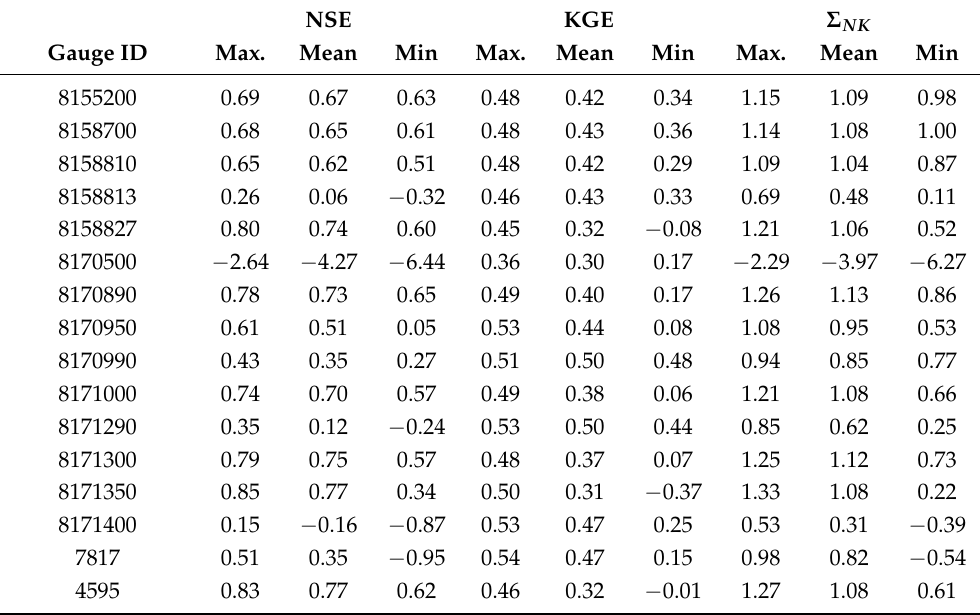
Table 6. Monthly ‘goodness-of-fit metrics’ between gauge discharge and synthetic, biased discharge time series. NSE KGE Σ NK Gauge ID Max. Mean Min Max. Mean Min